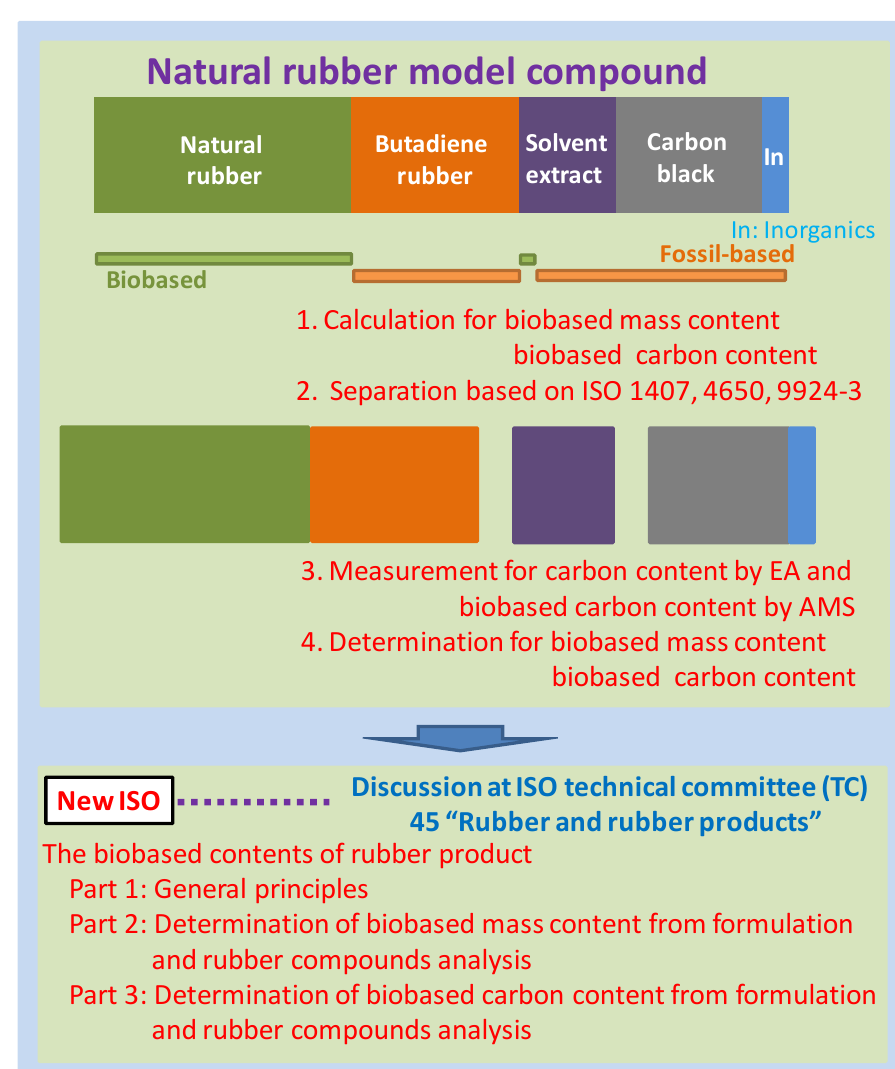
Figure 8. Determination methods of biobased contents for ISO evaluation